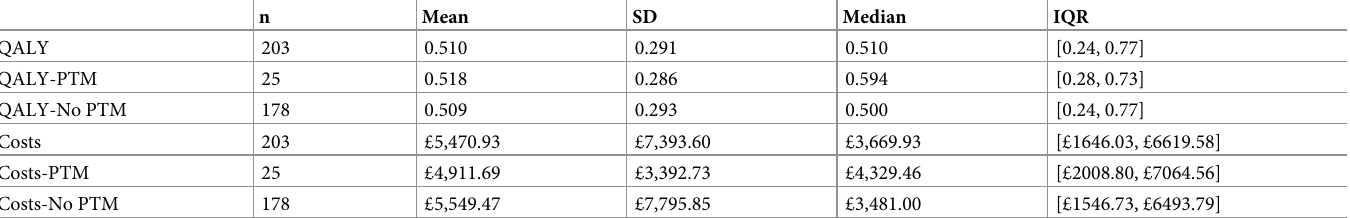
Table 3. Summaries of the Quality of Life Years (QALY) and costs, both overall and stratified by the study outcome (occurrence of a procedure tract metastasis, or PTM).